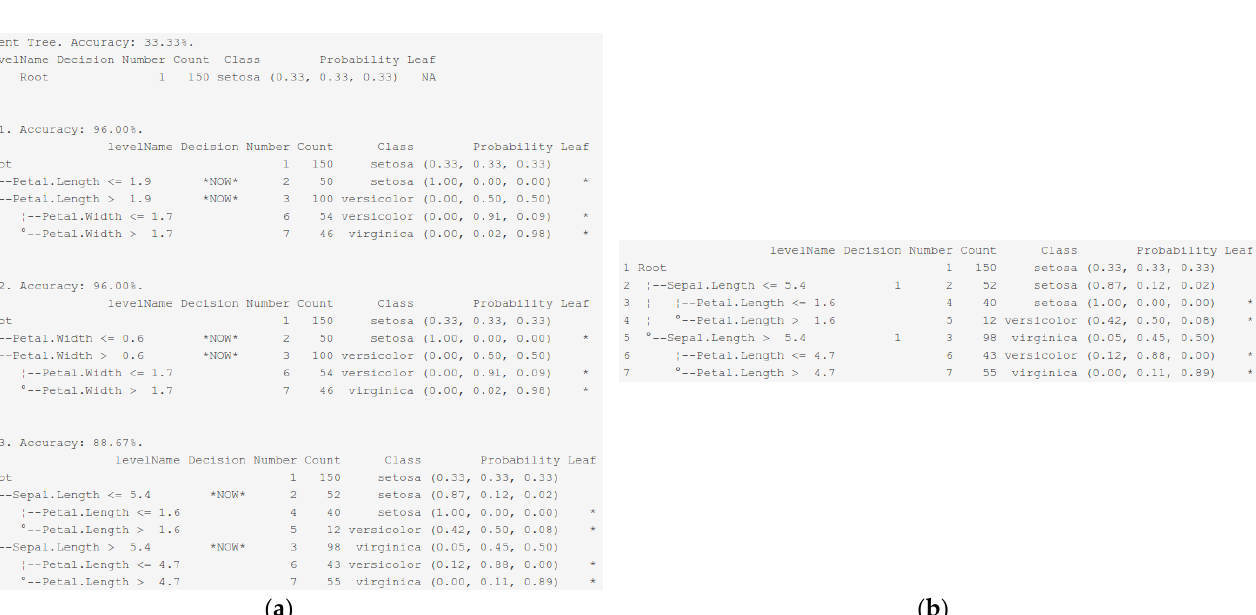
Figure 4. Decision rules generated from the final tree structure built from scratch.